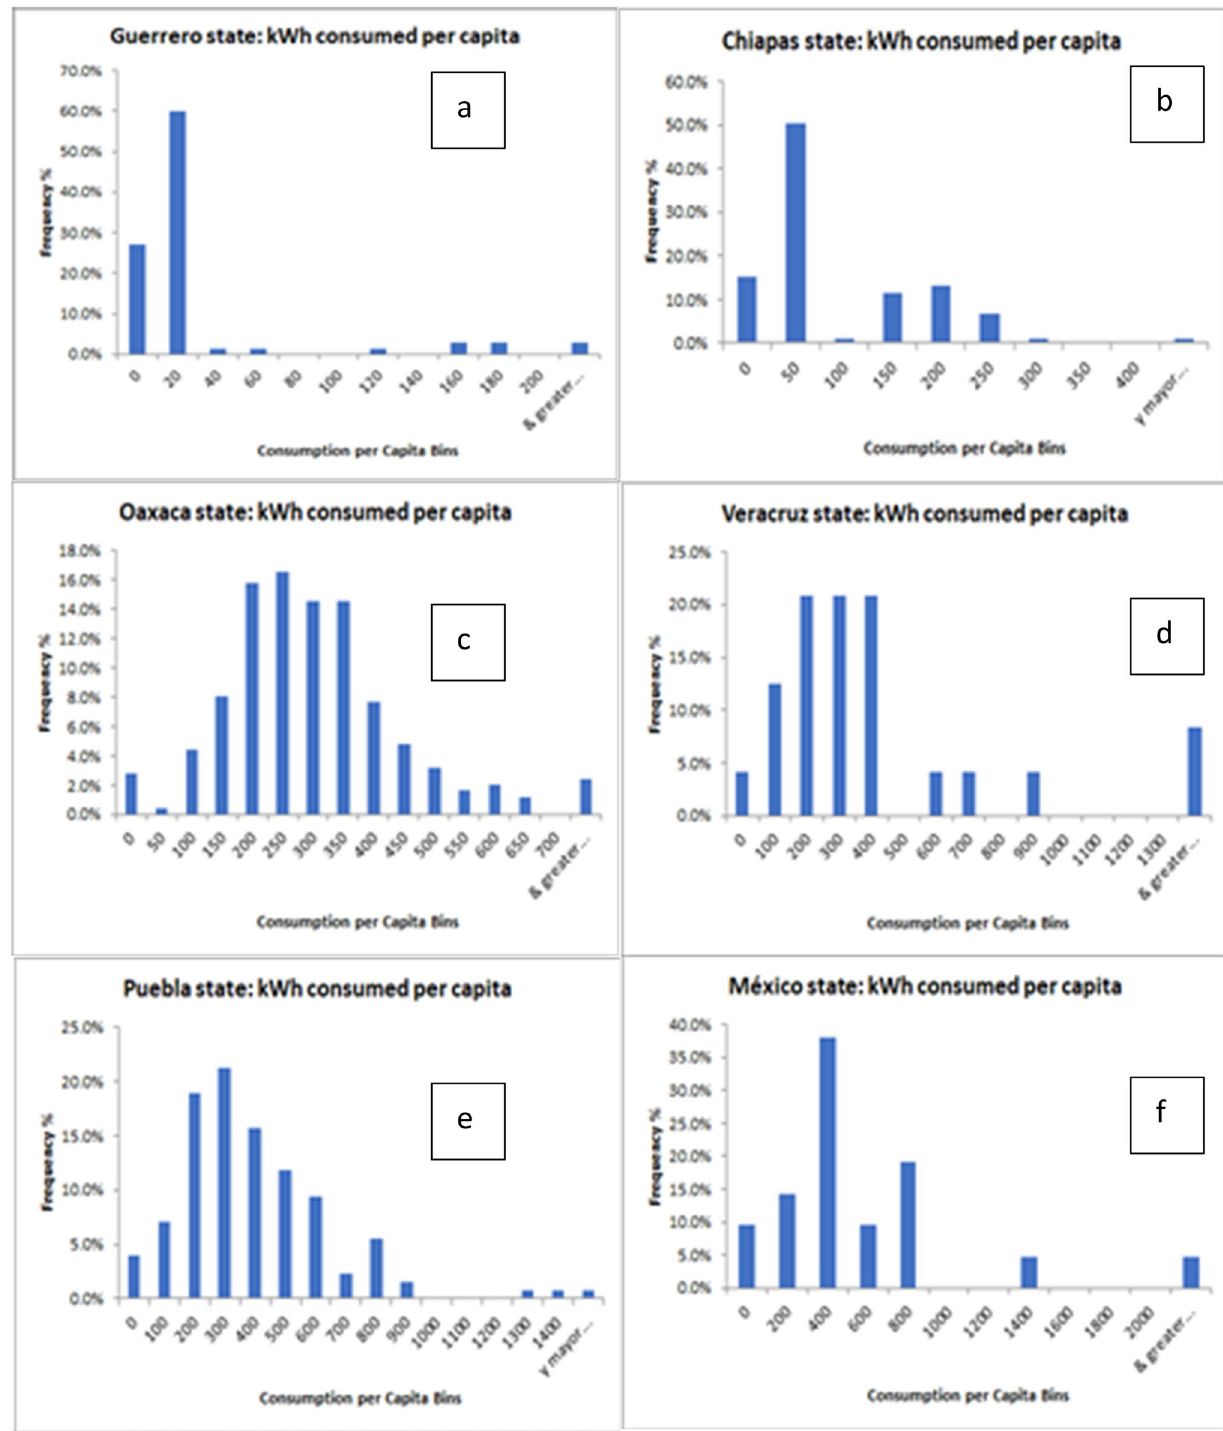
Fig. 14 Histogram for Electricity consumed per capita (kWh/capita) for IM > 0 in several states. Weighted value: a Guerrero [25], b Chiapas [90], c Oaxaca [281], d Veracruz [292], e Puebla [383], f México